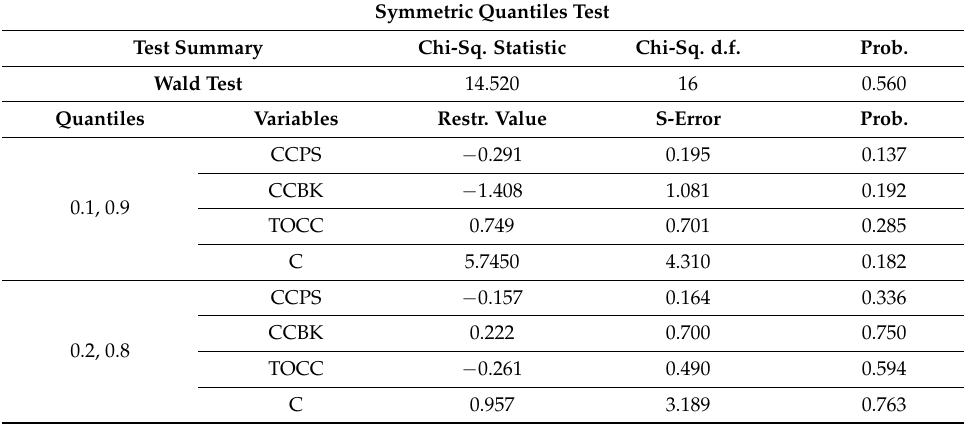
Table 6. Consequences of symmetric quantile